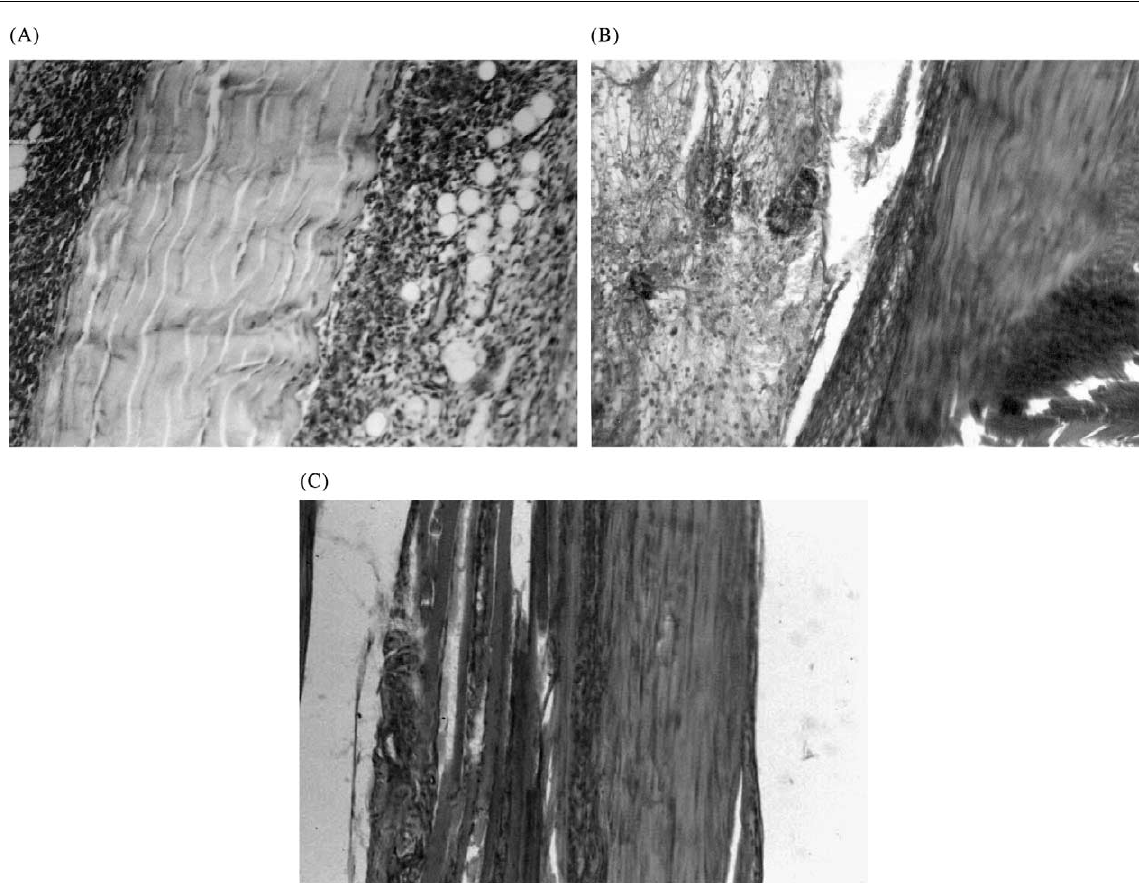
FIG. 4. Three weeks after tendon injury in the rat ( (cid:4) / 10, haematoxylin and eosin). (A) Control, no treatment: inflammatory cell numbers in the subcutaneous tissue is much reduced, although mononuclear cells are still present in the extensive areas where adhesions have formed. In these areas the synovial space is completely obliterated by adhesion formation. Reproduced by kind permission from Martin Dunitz Ltd (1997). (B) and (C) L-NAME treatment: inflammatory cell accumulation in the subcutaneous tissue is still severe and persistent, and large numbers of mononuclear cells are present in the areas where adhesions have formed between the synovium and tendon. The adhesions between tendon and synovium have increased and matured.